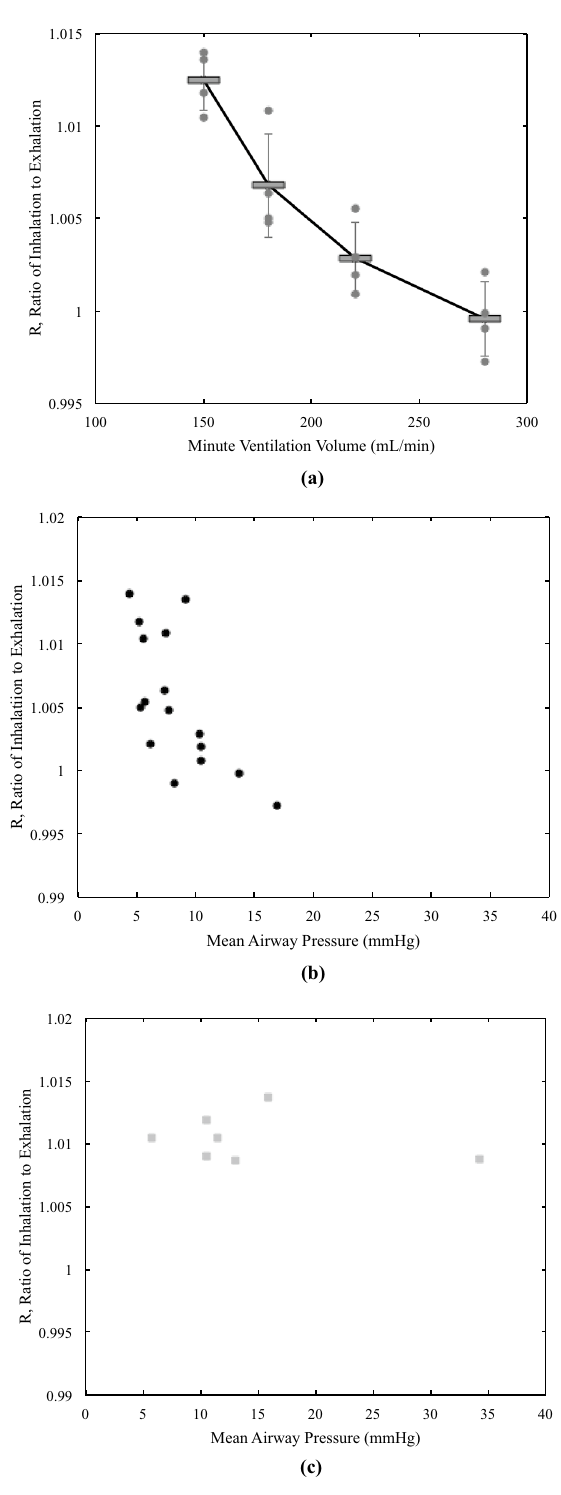
Figure 6. Effects of Volume and Pressure of Ventilation on R. ( a ) R is shown as a function of MVV (minute ventilation volume) ranged from 150 mL/min to 300 mL/min. R decreased to 1.0 as MVV increased. ( b ) The mean airway pressure changed from 4.4 to 16.8 mmHg as MVV increased from 150 to 280 mL/min and so there was a correlation of R with the airway pressure. ( c ) In a separate experimental setting at a fixed MVV of 180 mL/ min, there were no significant changes in R at a range of the mean airway pressure from 5.7 to 34.2